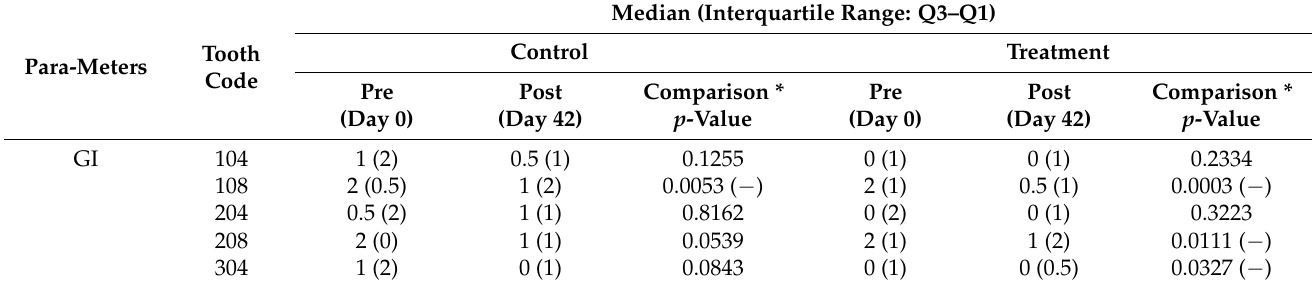
Table 2. Median, interquartile values, and comparison (pre- vs. post-treatment) of the gingival index (GI) and plaque index (PI) for control and treatment